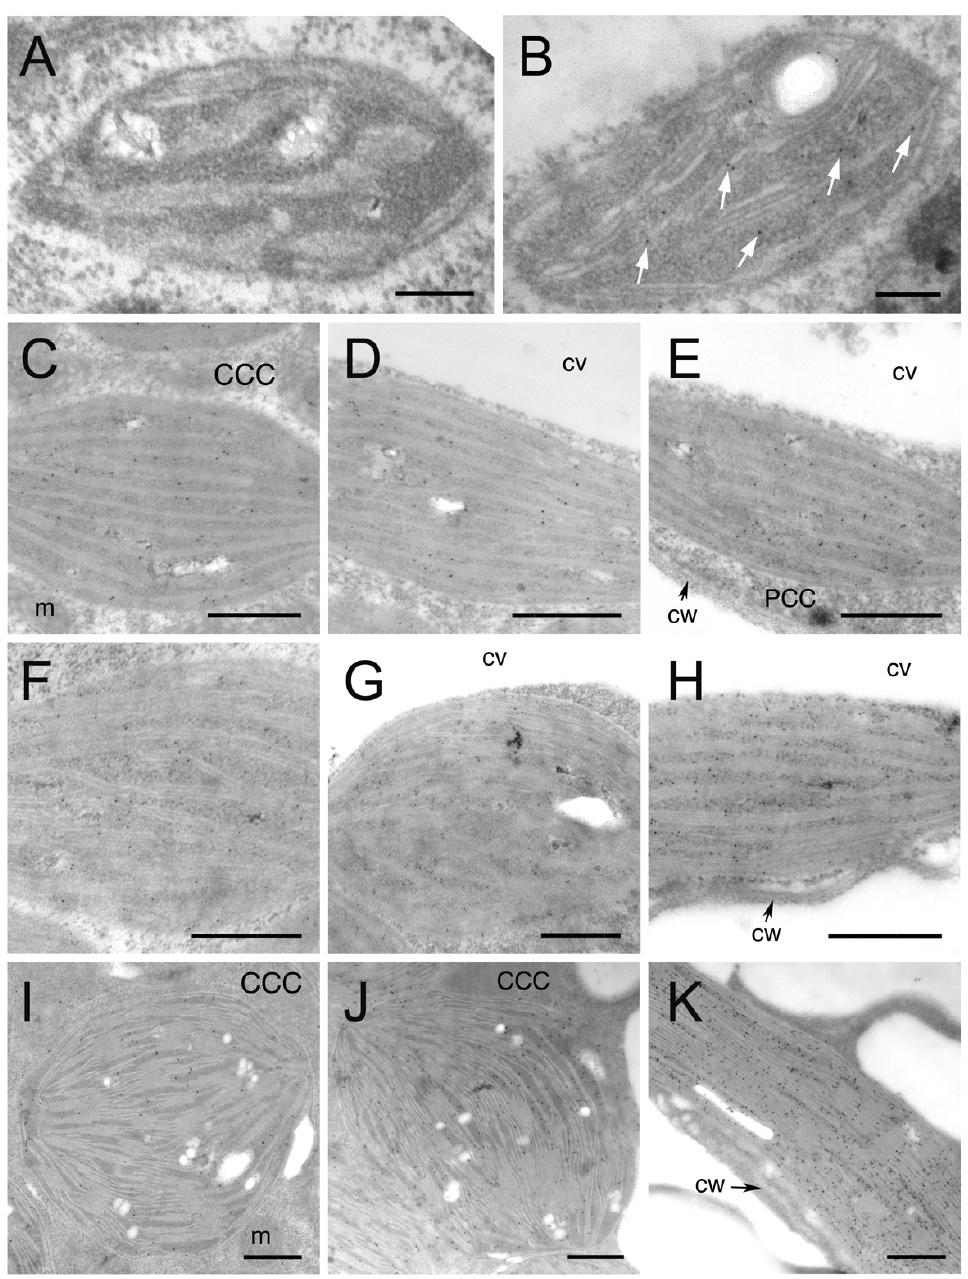
Figure 3. Immunolocalization of PPDK in chloroplasts in developing leaves of B. sinuspersici . Leaf cross-sections from various developmental stages were probed with PPDK antiserum and then with a gold-conjugated secondary antibody. Images are transmission electron micrographs of chloroplasts in ( A ) youngest, ( B ) young, ( C – E ) intermediate, ( F – H ) premature, and ( I – K ) mature leaves showing specific reaction of the PPDK antibody. Starting from the intermediate stage, the CCC and PCC ( E , H , K ) are evident. Chloroplasts in the CCC were further divided into the inner layer of CCC (CCCI: C , F , I ), and outer layer of CCC (CCCO: D , G , J ). White arrows indicate gold particles ( B ). CCC, central cytoplasmic compartment; PCC, peripheral cytoplasmic compartment; cv, central vacuole; cw, cell wall; m, mitochondria. Bars = 200 nm ( A , B ) or 500 nm ( C – K ).